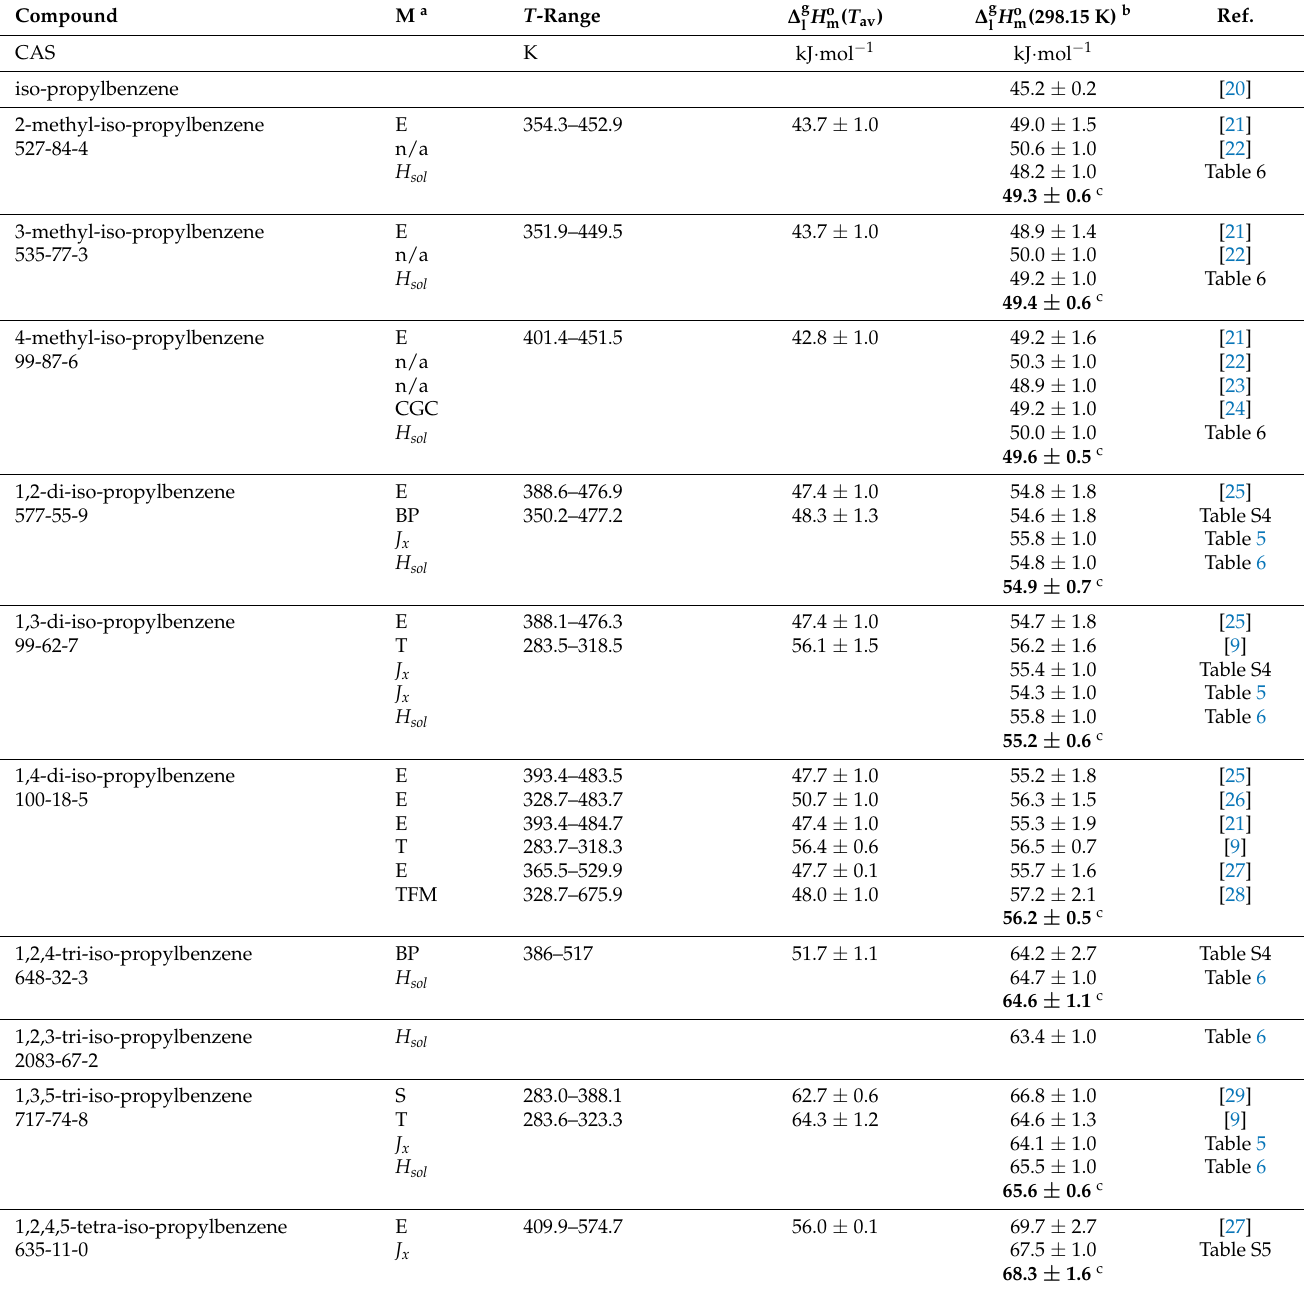
Table 1. Compilation of the enthalpies of vaporisation, ∆ g determined in this work and from the data available in the